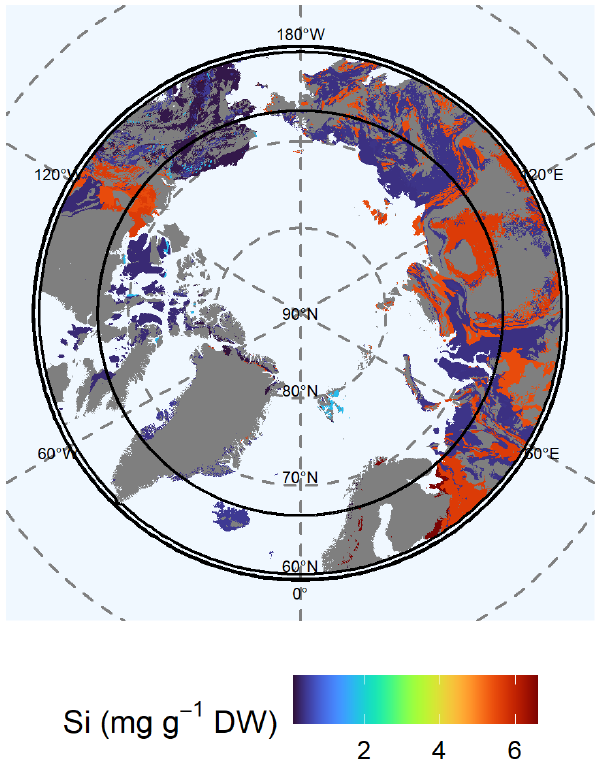
Figure 4. Map of the mean concentration of available (Mehlich-III- extractable) silicon (Si) for the uppermost 100cm of soils. For each lithological class, the mean concentration is shown. Blue colors rep- resent low concentrations of available Si, whereas red colors repre- sent high concentrations. Gray shaded areas are not represented by our